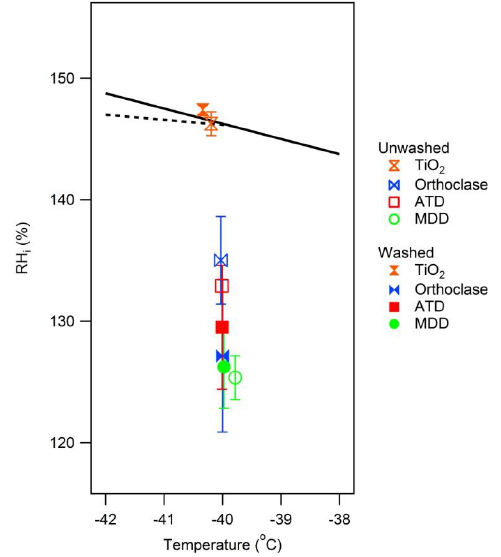
Fig. 4. Critical RH i at which 0.1% of particles were activated at a temperature of − 40.0 ± 0.3 ◦ C. The solid black line represents the water saturation line, and the dotted black line represents the homogeneous freezing line (Koop et al., 2000; Murphy and Koop, 2005). The solid markers indicate washed samples while the empty markers indicate unwashed samples of TiO 2 , orthoclase, ATD, and MDD. The error bars represent the standard deviation of the critical RH i , each of which is the average of at least three scans.